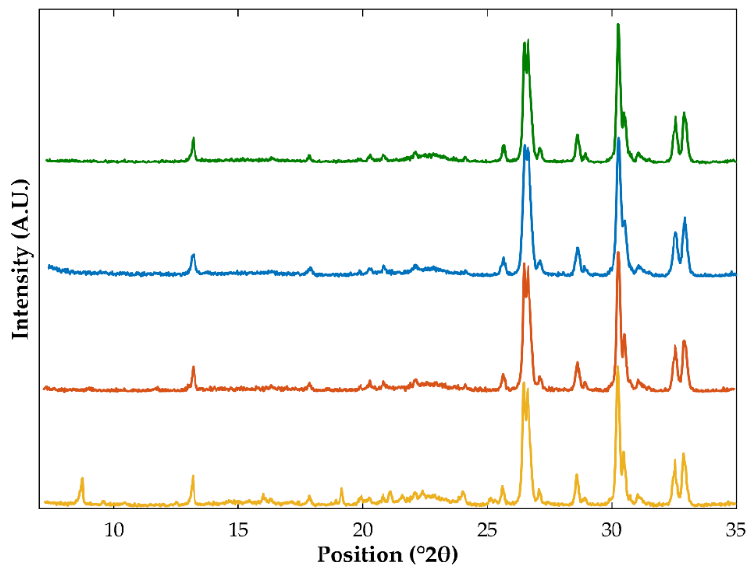
Figure 5. Diffractograms of samples prepared using crystalline olanzapine and saccharin (as starting material) obtained from the physical mixtures (yellow), extrudates (orange), and pellets (blue). The diffractogram of the physical mixture prepared using the co-amorphous olanzapine was plotted (green) for comparison purposes.